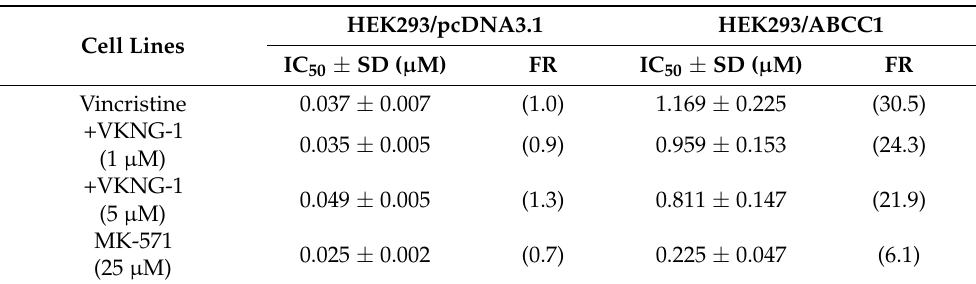
Table 4. The reversal effect of VKNG-1 on the cytotoxicity of anticancer drugs in ABCC1-transfected cell